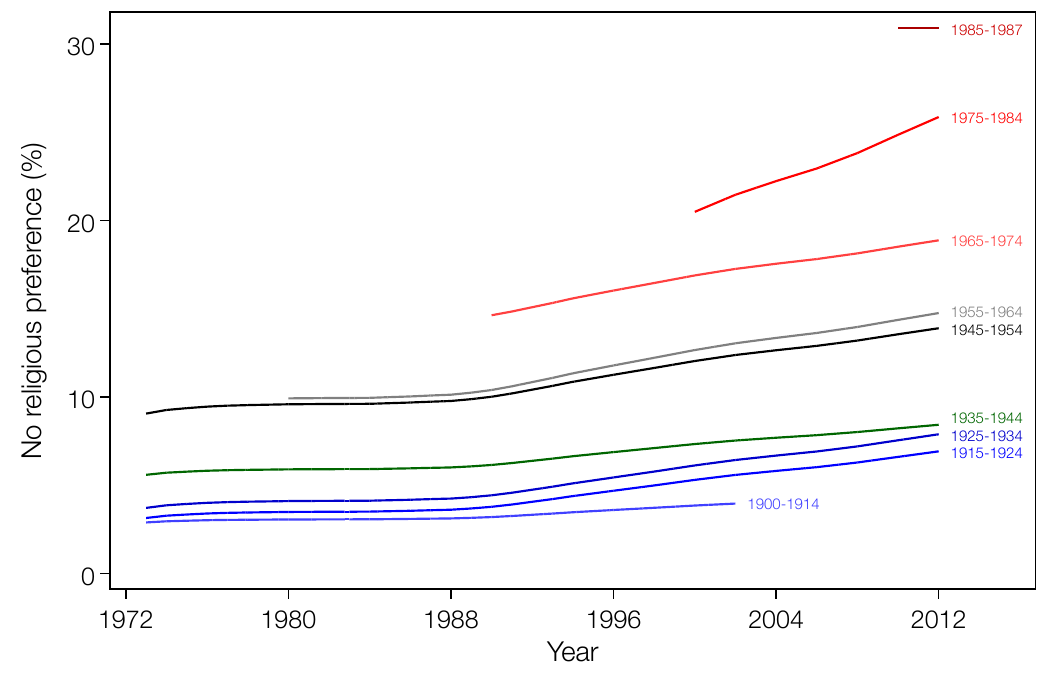
Figure 3: No Religious Preference (percent) by Year of Survey and Year of Birth: Adults, United States,